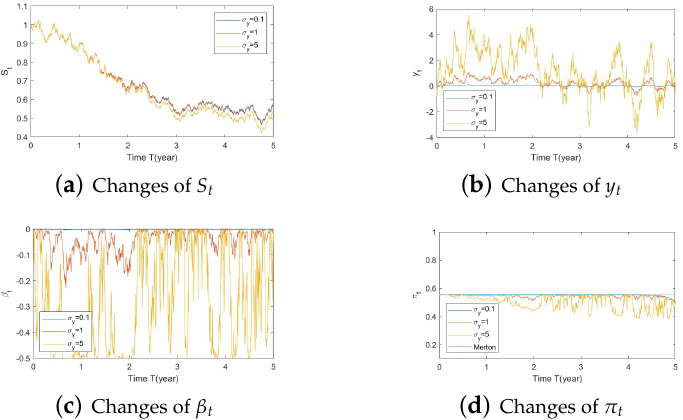
Figure A6. Illustrate the impact on ( a ) stock prices, ( b ) driver of elasticity, ( c ) elasticity of volatility, and ( d ) optimal stock allocations when varying σ y ( e . g ., σ y = 0.1,1,5 ) .